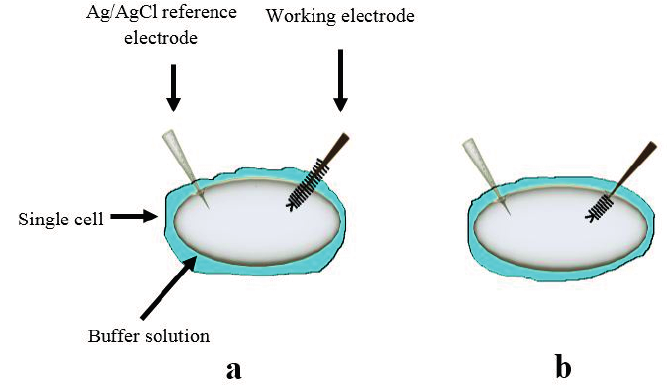
Figure 5. Schematic diagram showing the principle of measurements with different penetration depths during the experiment ( a ) the case with partial insertion of the functionalized ZnO nanorods and in ( b ) when all the functionalized ZnO nanorods are inserted inside the cell [5].